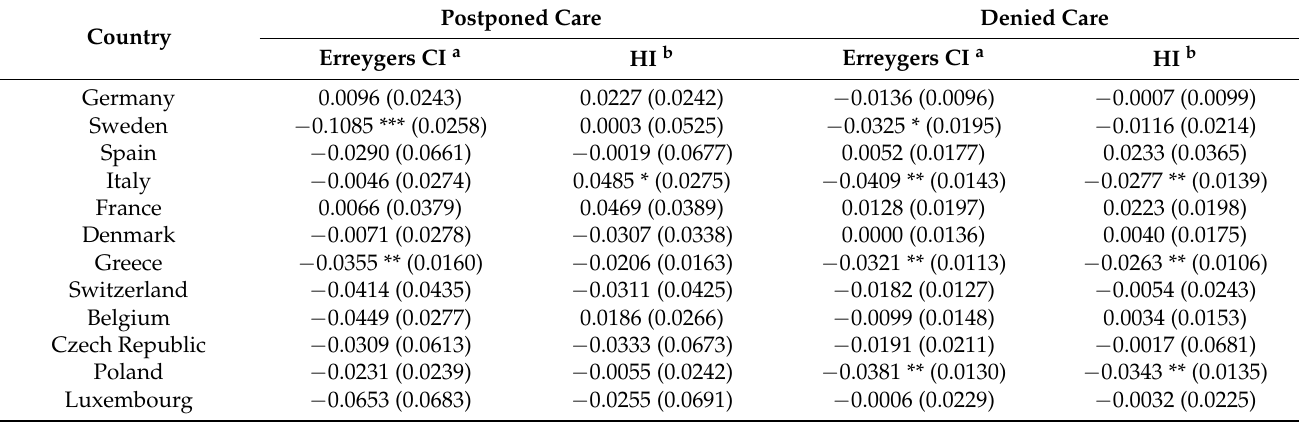
Figure 4. Horizontal inequity indices in denied health care during the COVID-19 pandemic across European countries. Note: red diamonds indicate p < 0.05. Bootstrapped bias corrected 95% confidence intervals.